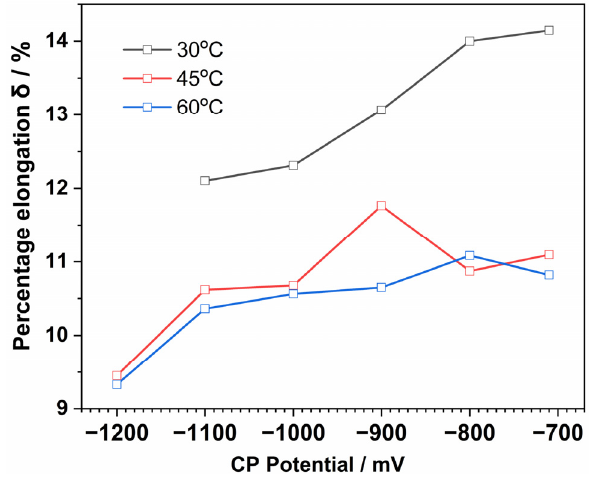
Figure 8. Elongation of the X80 steel under different CP potentials in the soil medium.